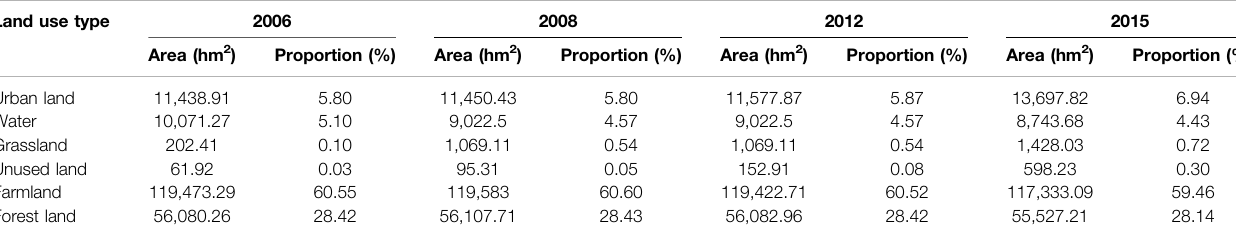
TABLE 3 | Area statistics of different land types in different